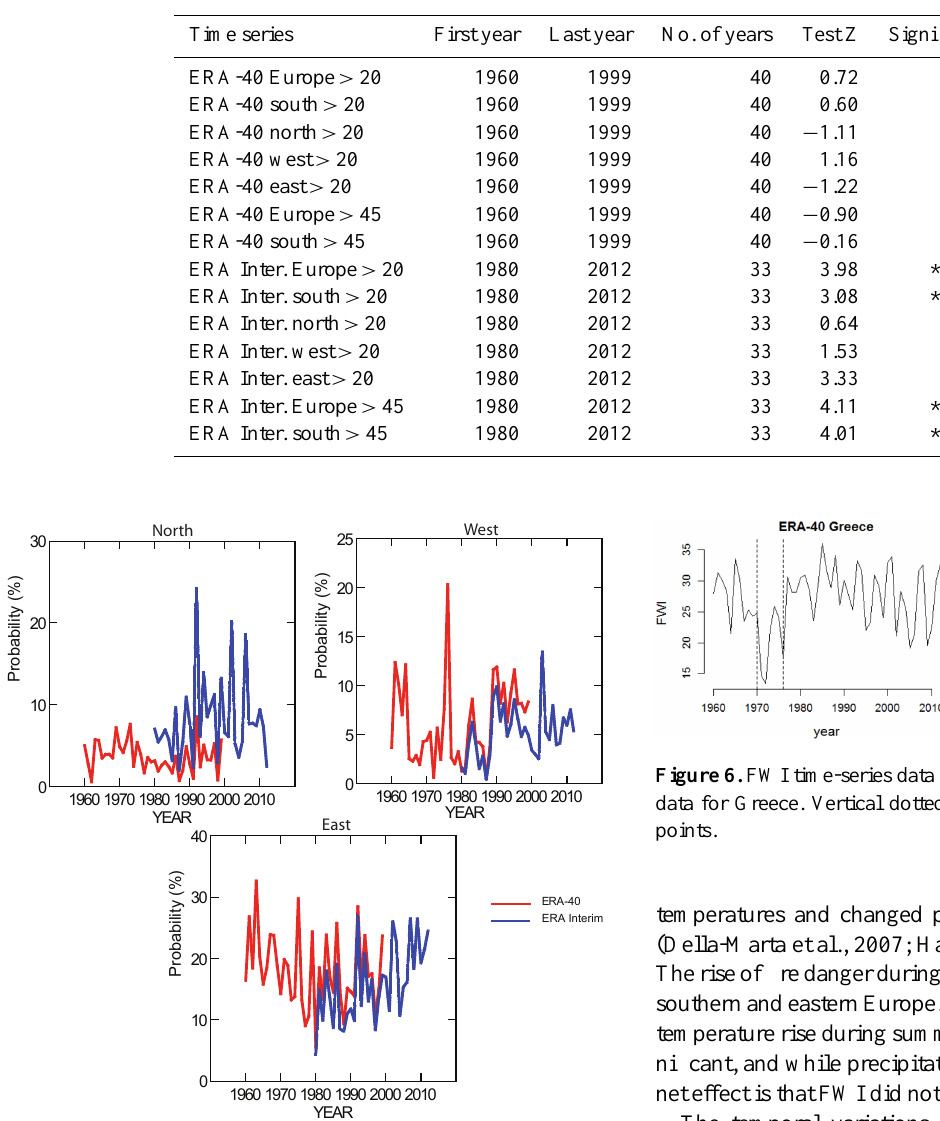
Table 2. Trend and gradient of the March–September FWI values higher than 20 or higher than 45 as calculated for the different areas of Europe (Fig. 1) using the modified Mann–Kendall test and Sen’s method and ERA-40 and ERA Interim data sets. The following symbols indicate significance at level α = 0.01 (***), α = 0.05 (**) and α = 0.1.